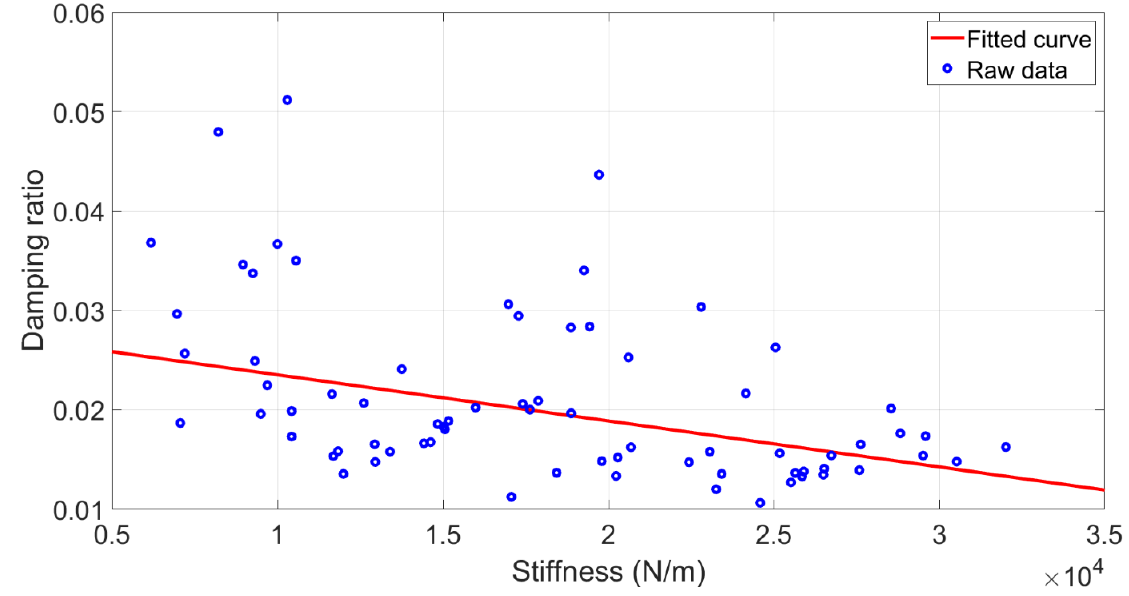
Figure 8. The fitted curve for stiffness and damping ratio. Table 7. Regression coefficients for Multiple Linear Regression (MLR) correlation between process parameters and stiffness.